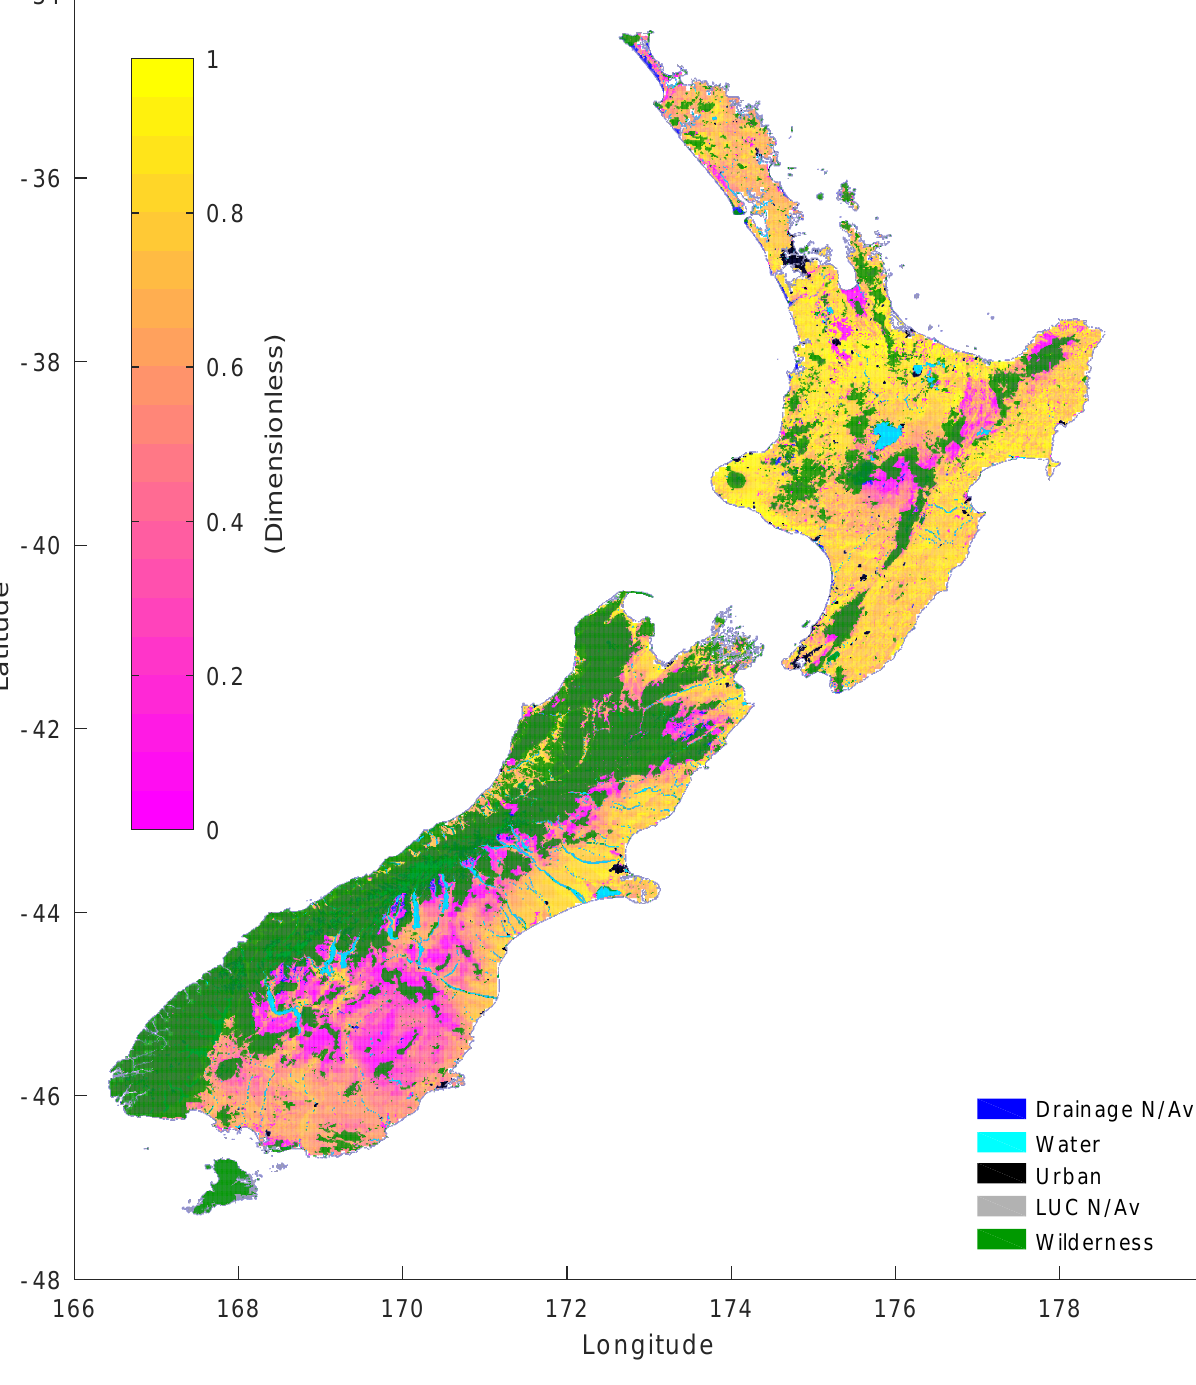
Figure 9. Location suitability scores for apple across New Zealand. N/av indicates data were not available. LUC is Land Use Capability classification. Wilderness areas encompass national parks, reserves, conservation areas and marginal